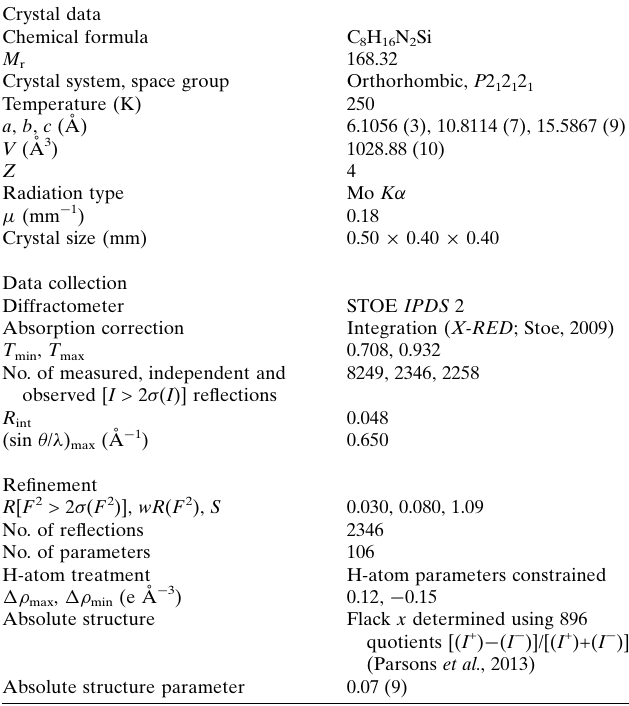
Table 1 Hydrogen-bond geometry (A˚ , (cid:5) ).